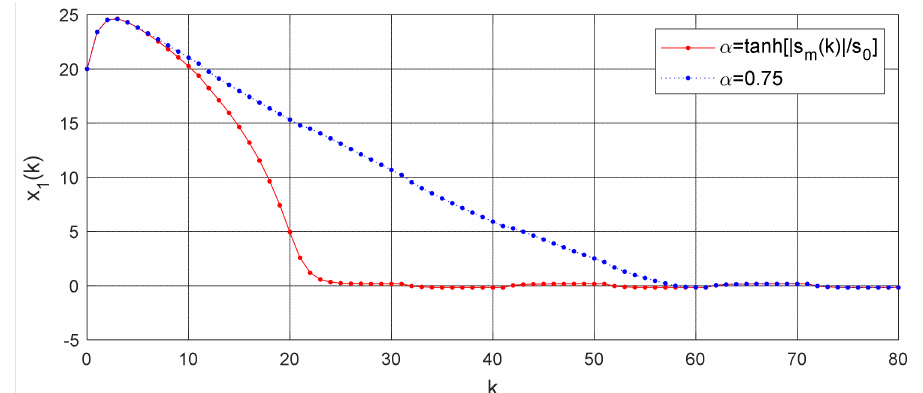
Figure 7. Evolution of the first state variable x 1 ( k ).